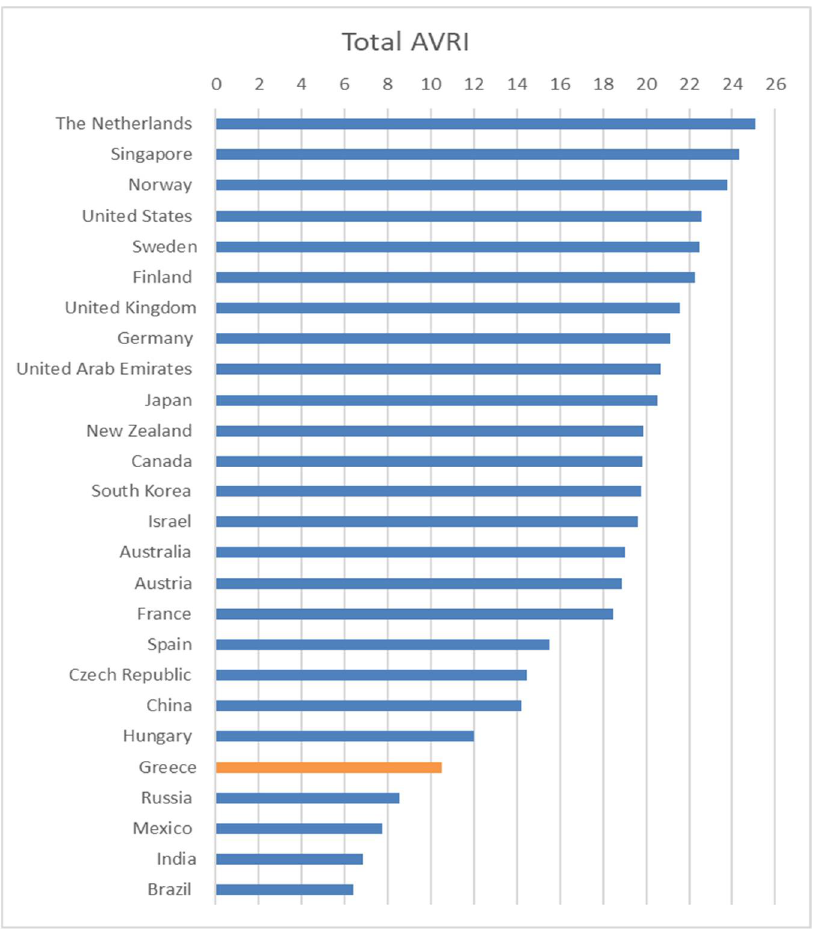
Figure 7. Greece’s AVRI overall listing.